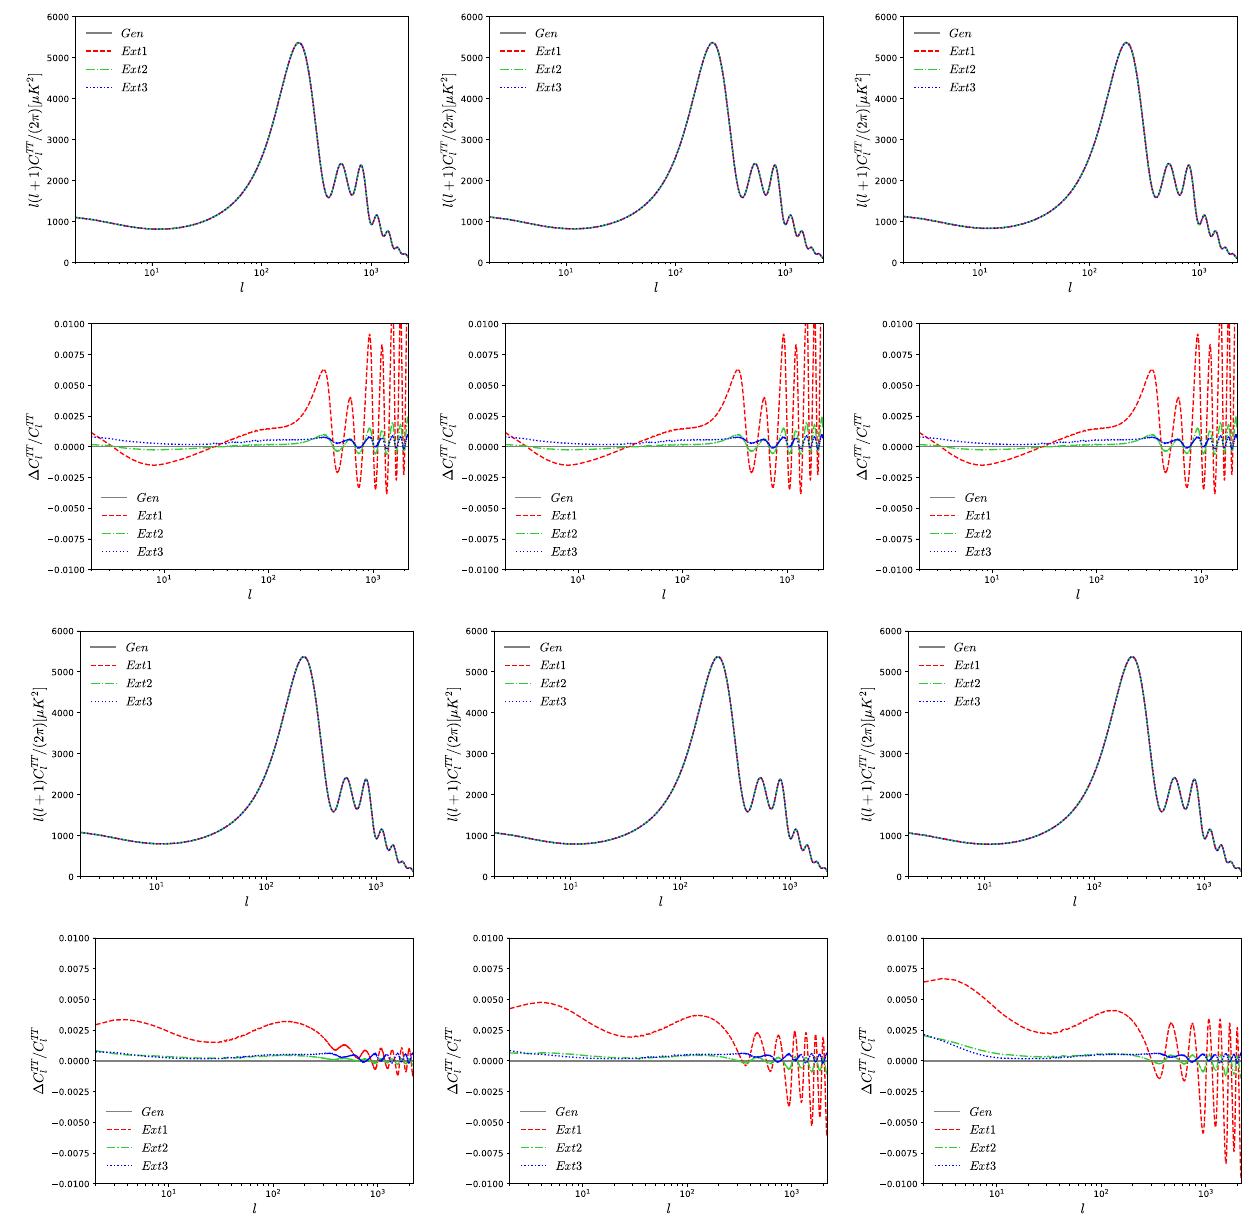
Fig. 11 We show the cosmic microwave background spectra and the corresponding residual plots for the present dynamical dark energy parameterizations using various values of the w a parameter with a fixed w = − 0 . 95. The plots in the first row present the cosmic microwave 0 background spectra and the plots in the second row present the corre- spondingresidualplots.Theplotsfromlefttorightinthefirstandsecond